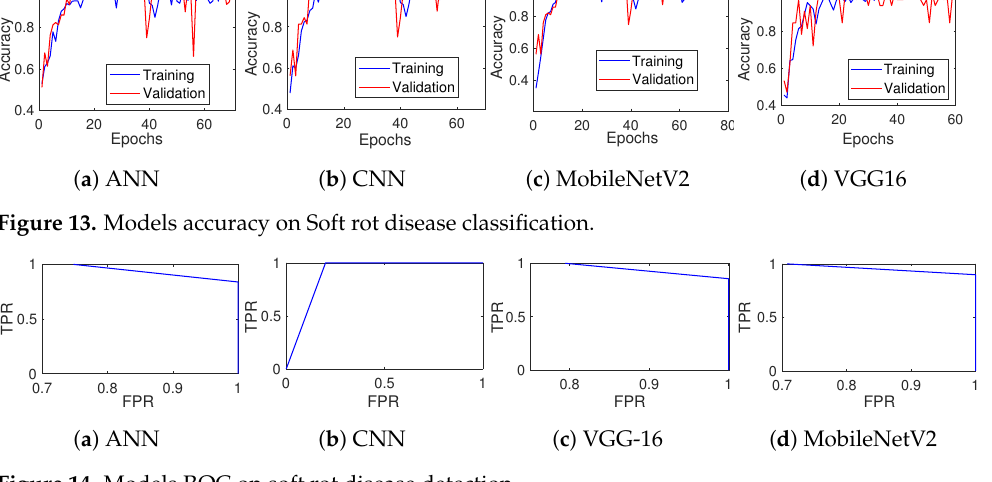
Figure 14. Models ROC on soft rot disease detection.